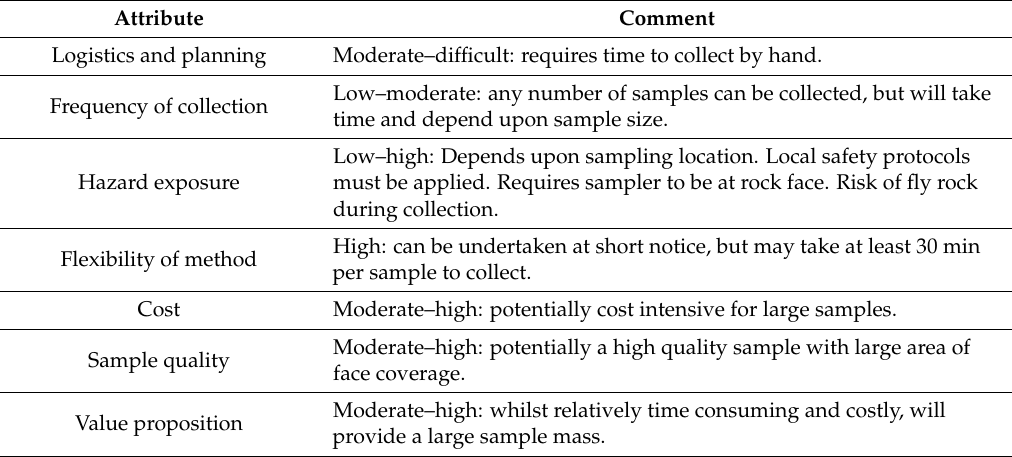
Table 13. Panel sample